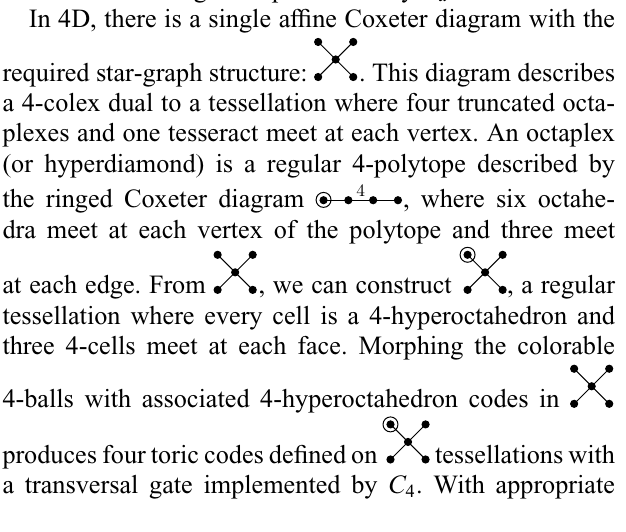
5 using Wythoff’s construction. Toric